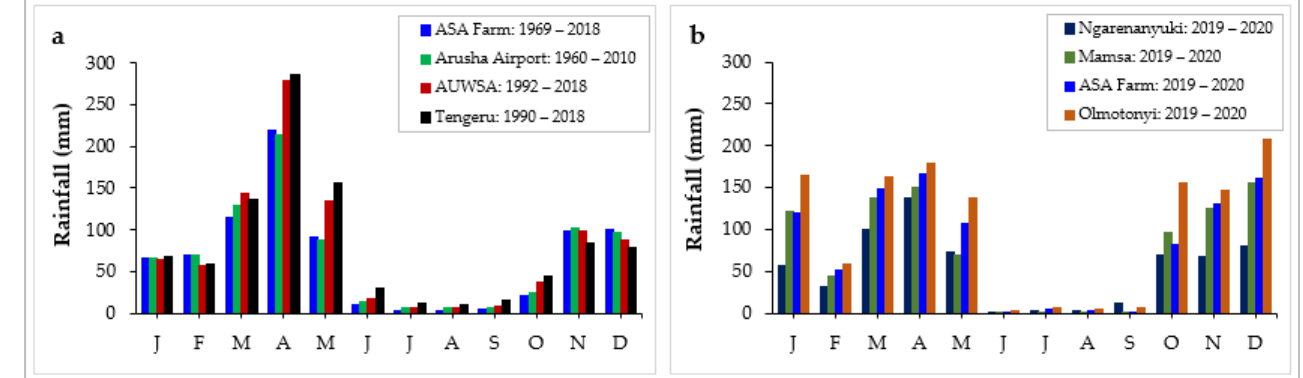
Figure 2. ( a ) Average monthly rainfall for the four existing rainfall stations and ( b ) average monthly rainfall for the four new installed rainfall stations.